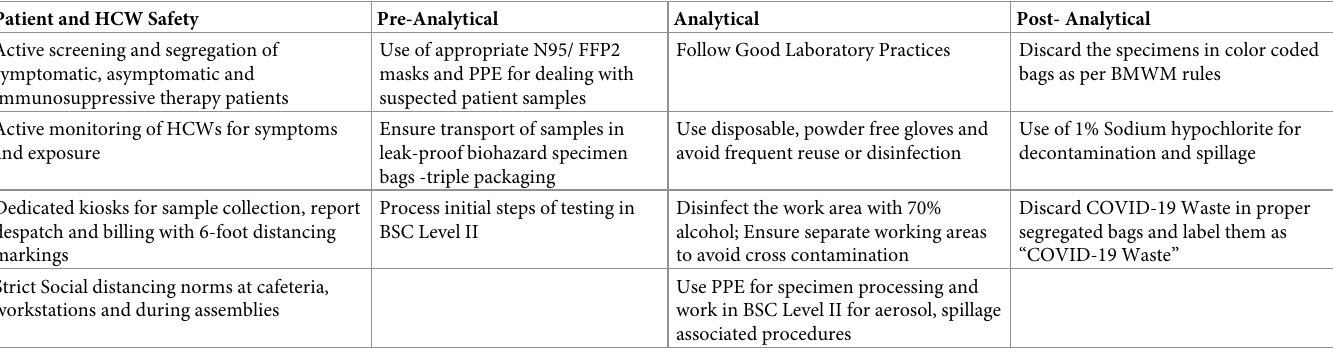
Table 2. Summary of precautionary measures to be taken for dealing with patients and diagnostic samples. Patient and HCW